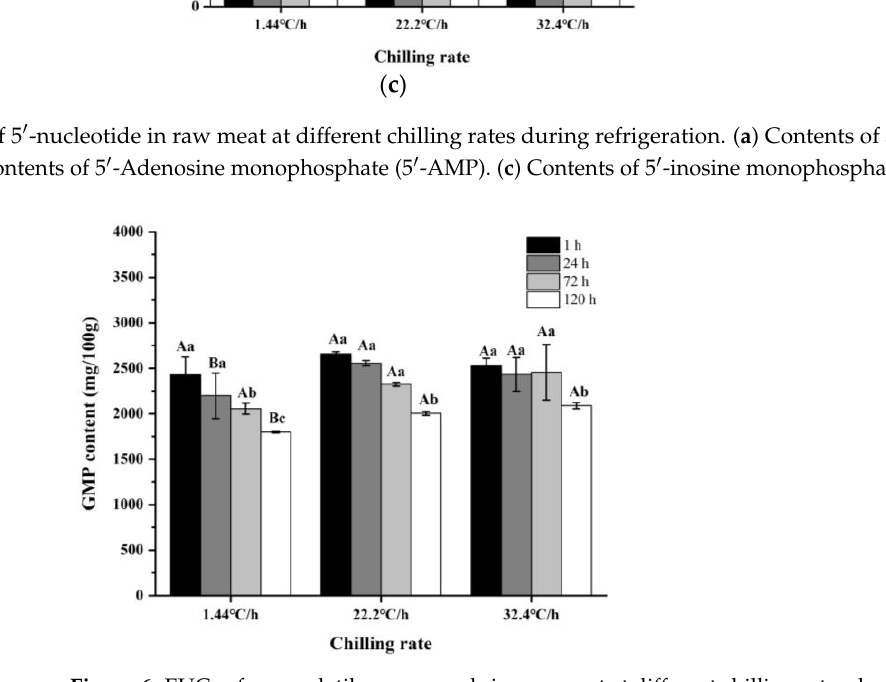
Figure 6. EUCs of non-volatile compounds in raw meat at different chilling rates during refrigera- tion.